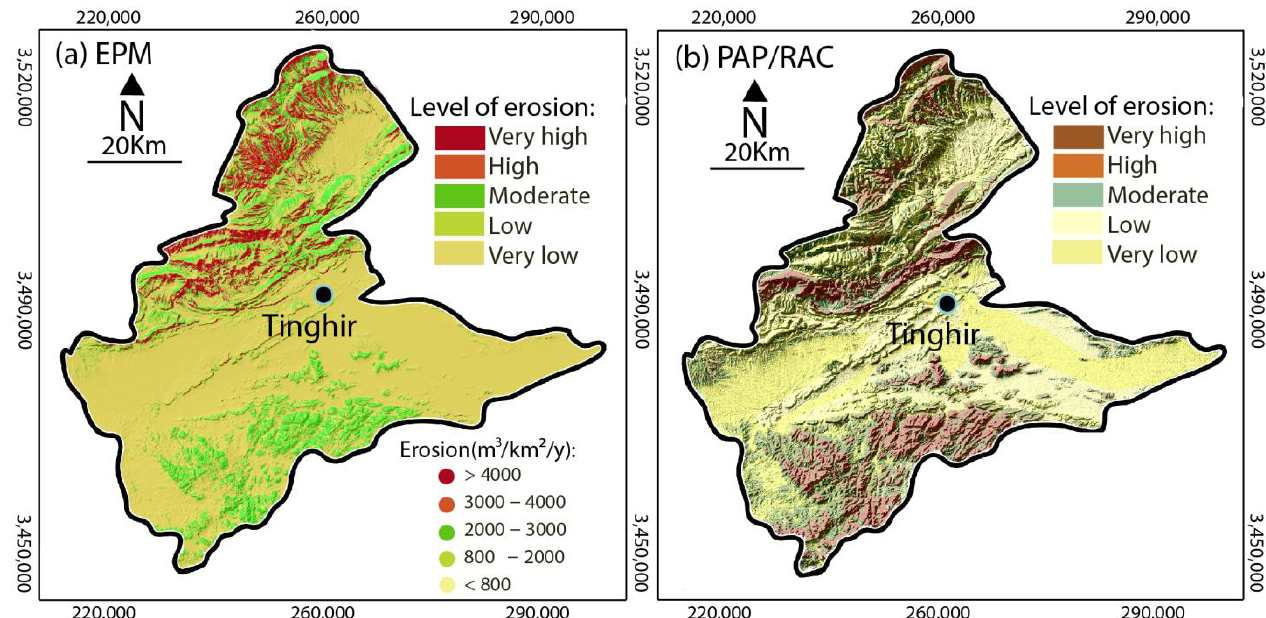
Figure 7. Maps of potential erosion risk of Toudgha River catchment. ( a ) EPM model and ( b ) PAP/RAC model.